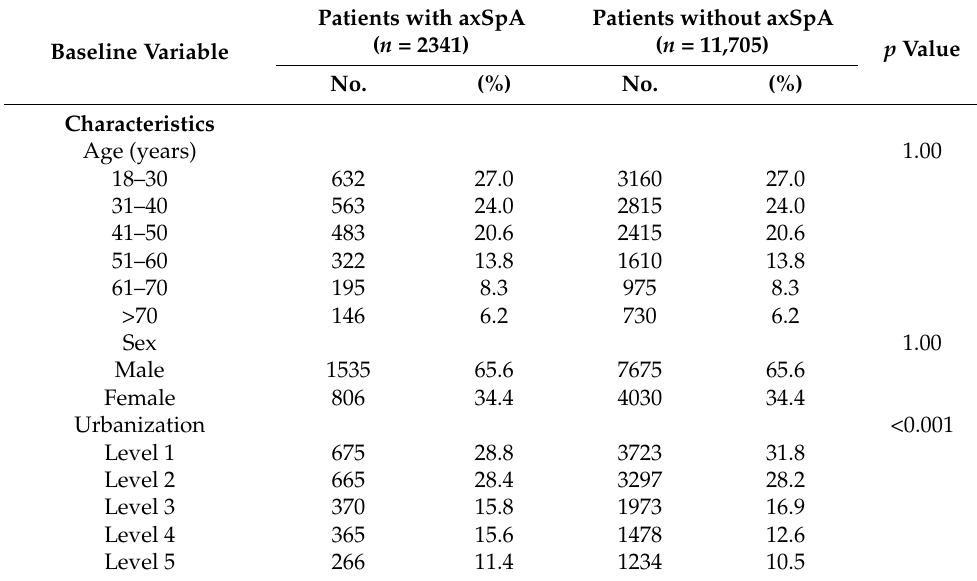
Table 1. Baseline demographic characteristics and comorbidities of age- and sex-matched patients in the axSpA and non-axSpA cohorts ( n =